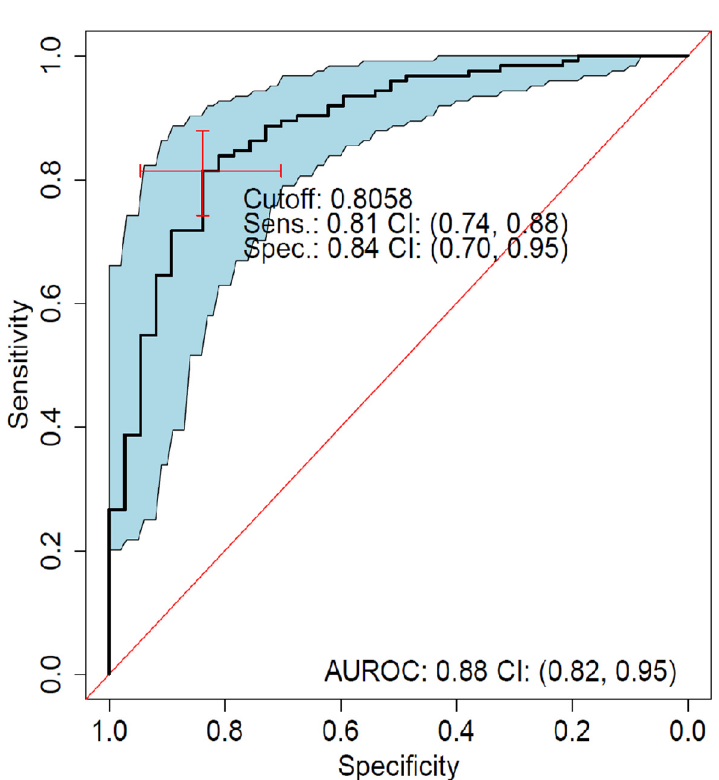
Figure 7. ROC analysis of predominantly classic versus occult external validation. Sensitivity versus specificity for all possible cutoff points with respect to predicted occult scores in AVENUE, including 95% CIs (bootstrapped). The location of the red crosshair indicates the operating point of the model. AUROC, area under the receiver operating characteristic; FA, fluorescein angiography; NEG, negative; POS, positive; ROC, receiver operating characteristic; Sens, sensitivity; and Spec, specificity. Table 7. The top 20 features from Figure 6 in descending order of importance.